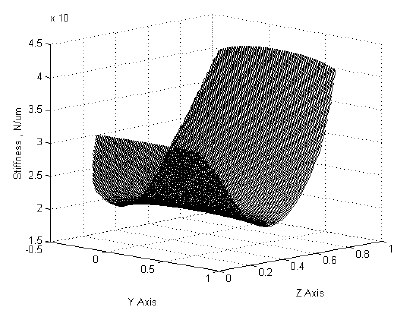
Figure 19: The Cartesian torsional stiffness in the X- direction as function of the Y- and Z- coordinates.